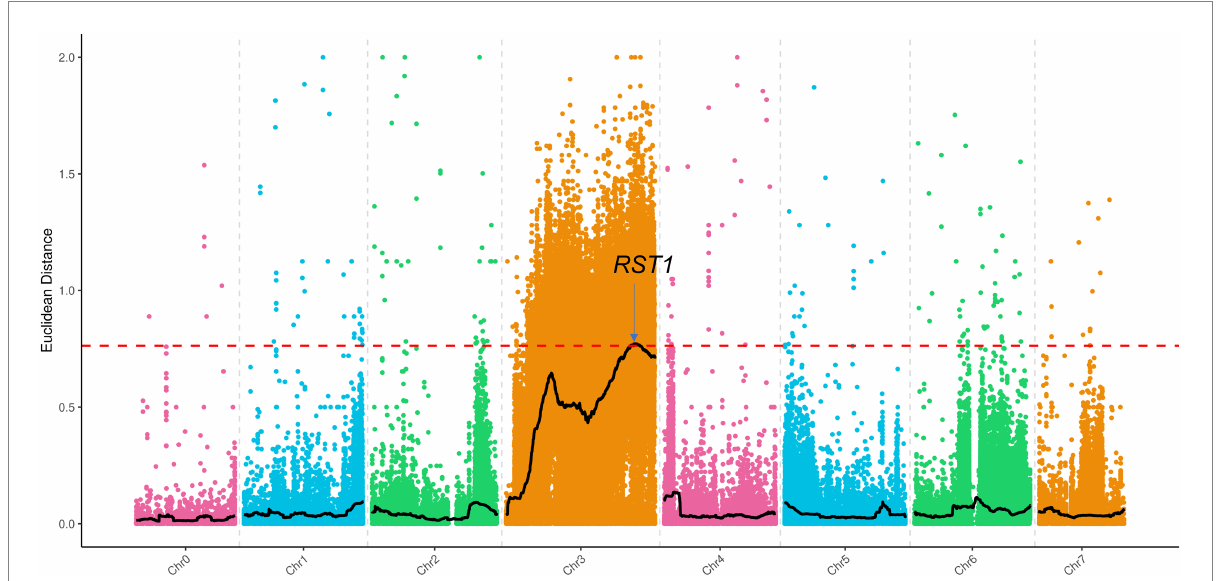
FIGURE 7 BSA-Seq approach for mapping the v-3 locus. The black lines show the results of ED, and the red lines show the threshold of ED. ED, Euclidean